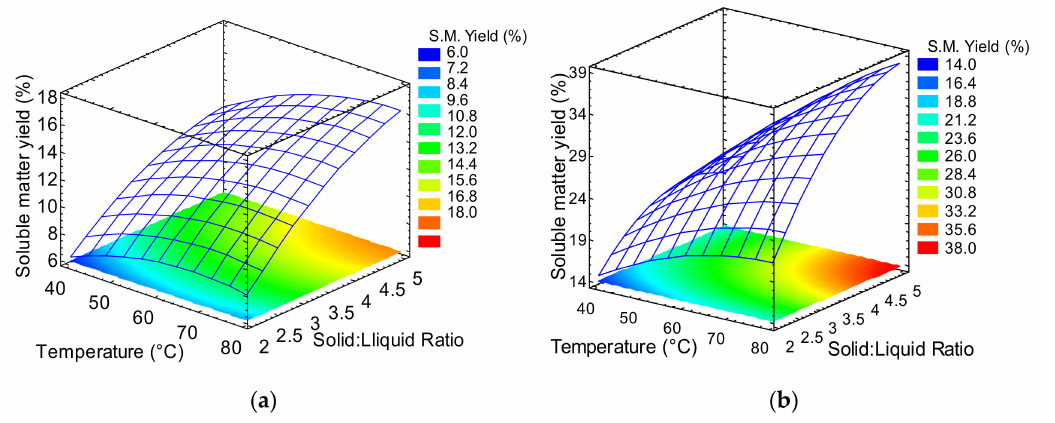
Figure 3. Response surface graphs of soluble matter yield as function of temperature and solid:liquid ratio (2 = 1:2, 3 = 1:3 and 5 = 1:5): ( a ) jicama (130 rpm), and ( b ) cabuya (300